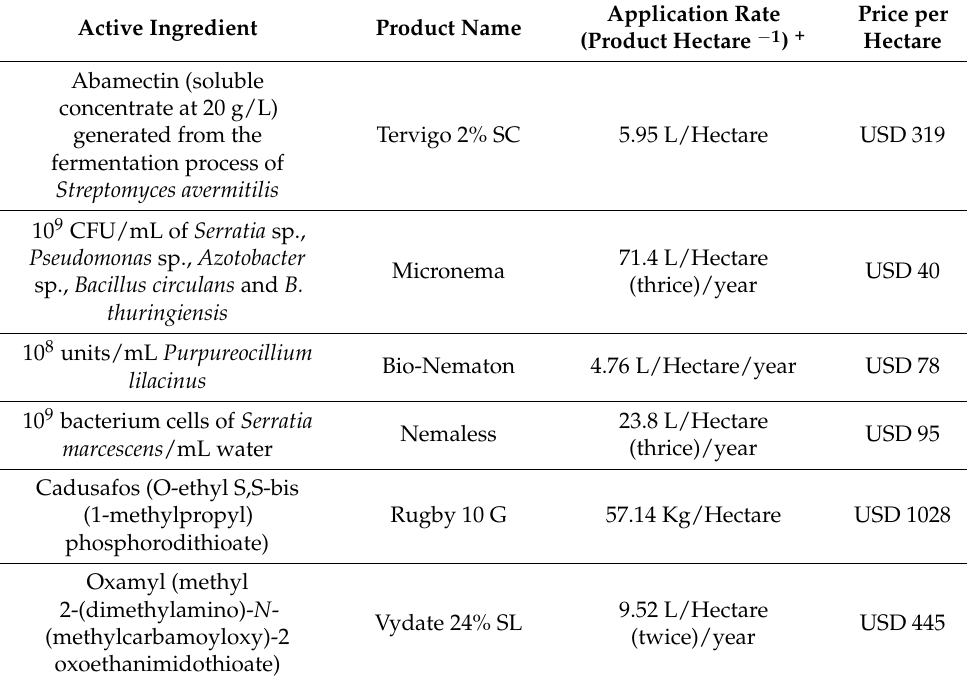
Table 2. Examples of bionematicidal product costs and used rates as compared to chemical nemati- cides in